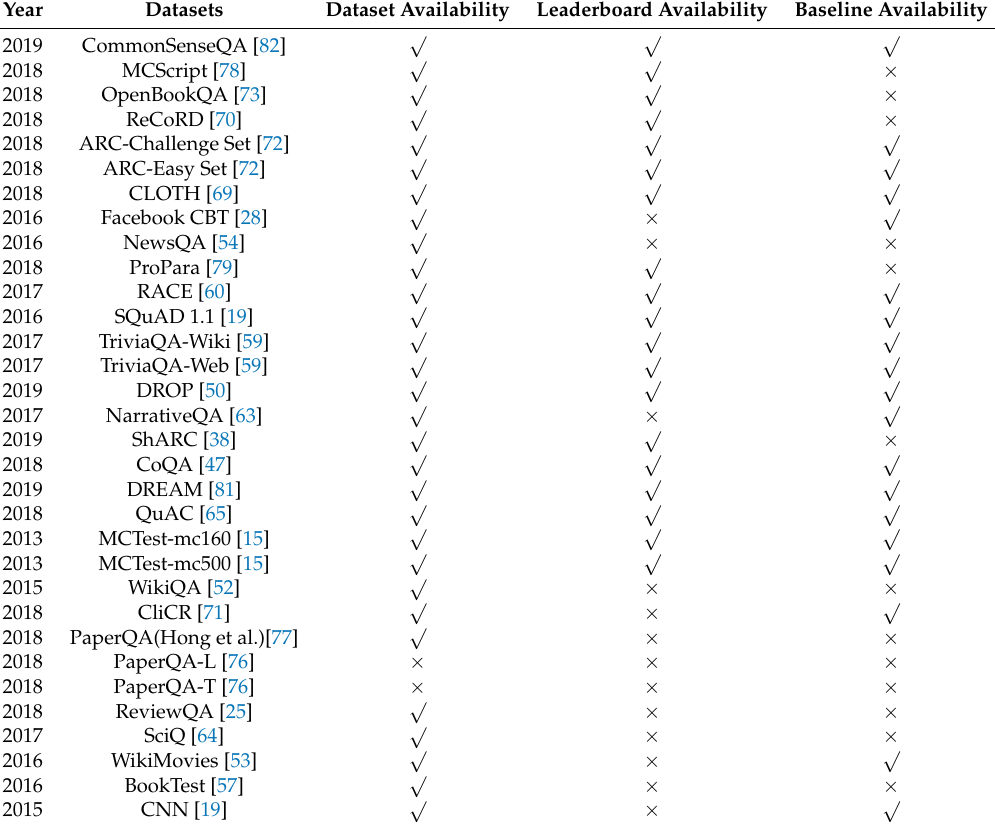
Table 7. The availability of datasets, leaderboards and